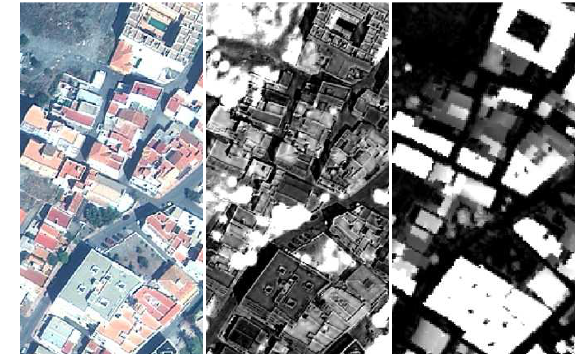
Figure 1. Location of the working area. Figure 2. From left to right, details of pansharpened orthoimage,